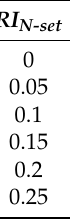
Table 1. Electricity cost under different robust indexes of the lighting